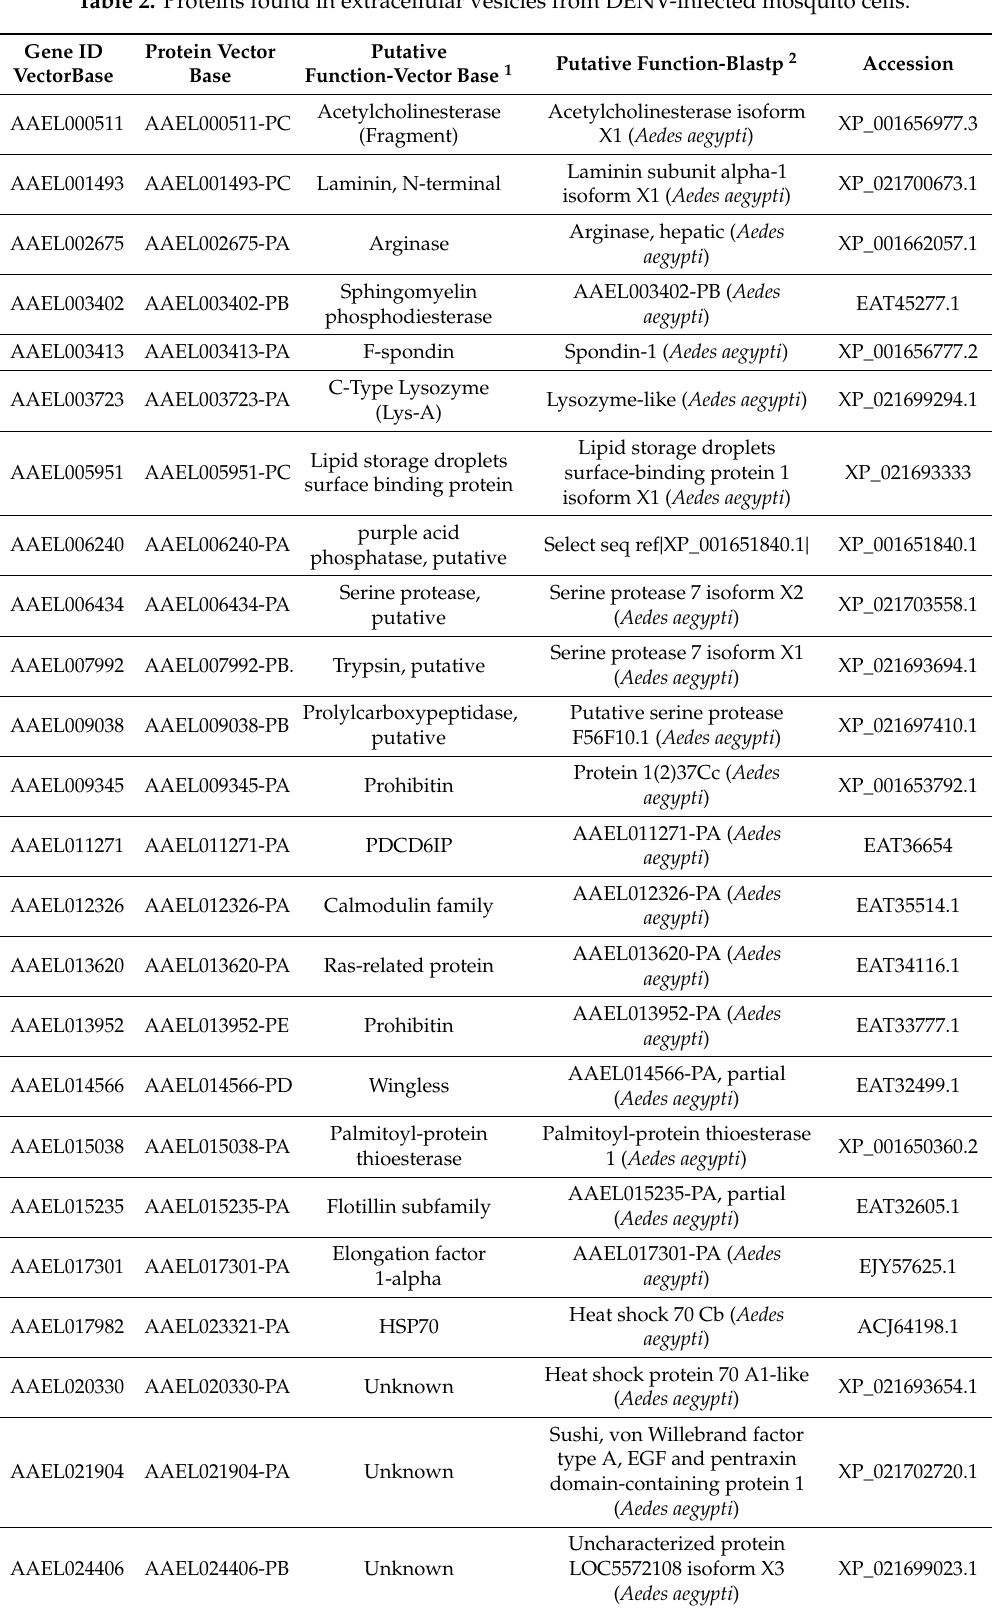
Table 2. Proteins found in extracellular vesicles from DENV-infected mosquito